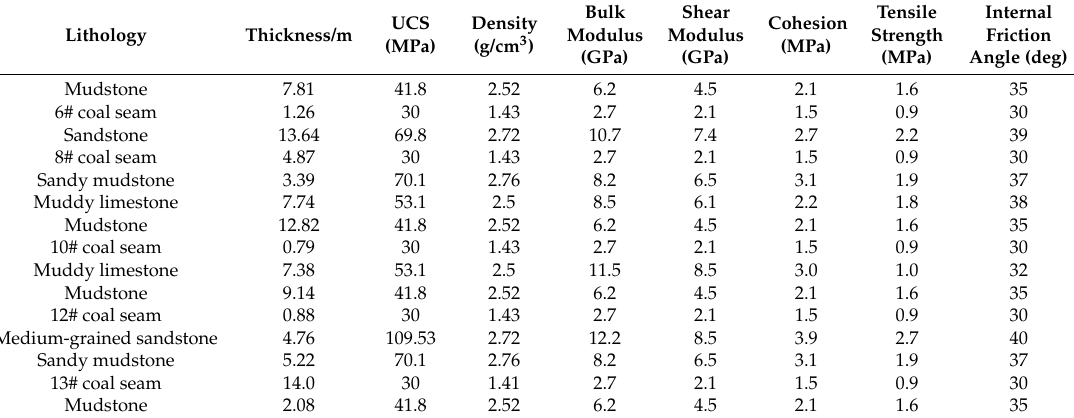
Table 3. Rock mass engineering properties used in numerical modeling.